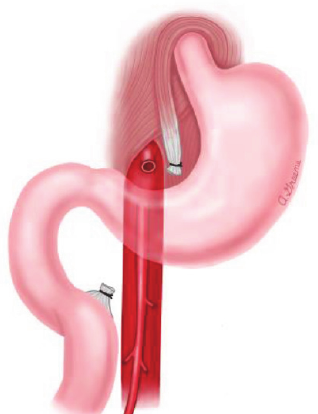
Figure 6: Strong’s procedure. Strong’s procedure mobilizes the duodenum by dividing the ligament of Treitz. Once the duodenal- jejunal junction is mobilized, the duodenum is positioned to the right of the superior mesenteric artery (Case Report One) (see [3]).